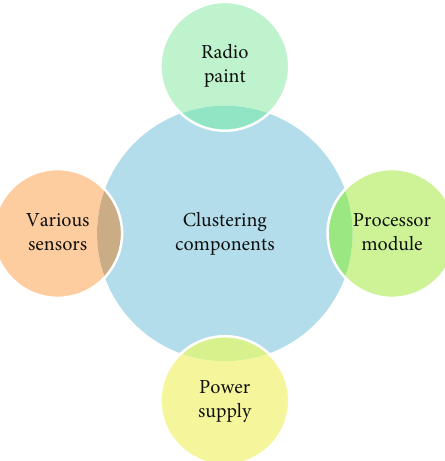
Figure 2: The proposed cluster formation